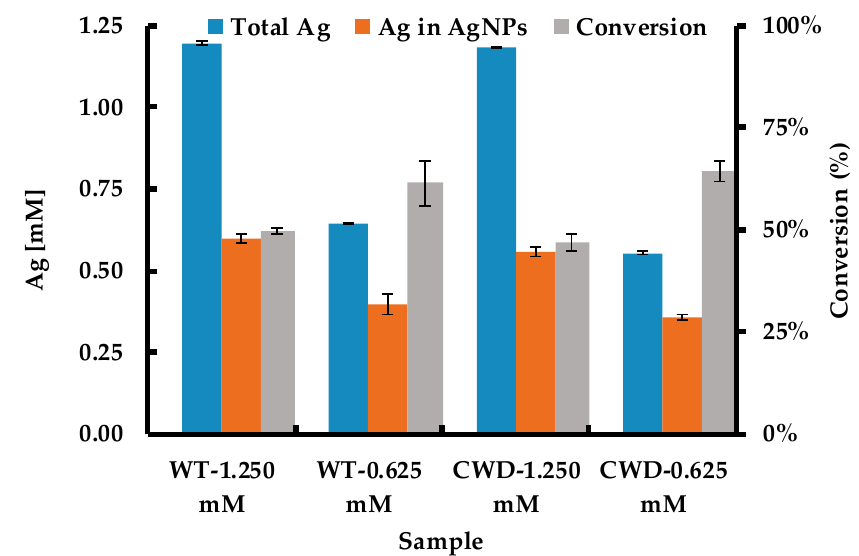
Figure 7. Biosynthetic conversion of Ag + to Ag 0 (final [Ag 0 ] mM/initial [Ag + ] mM).